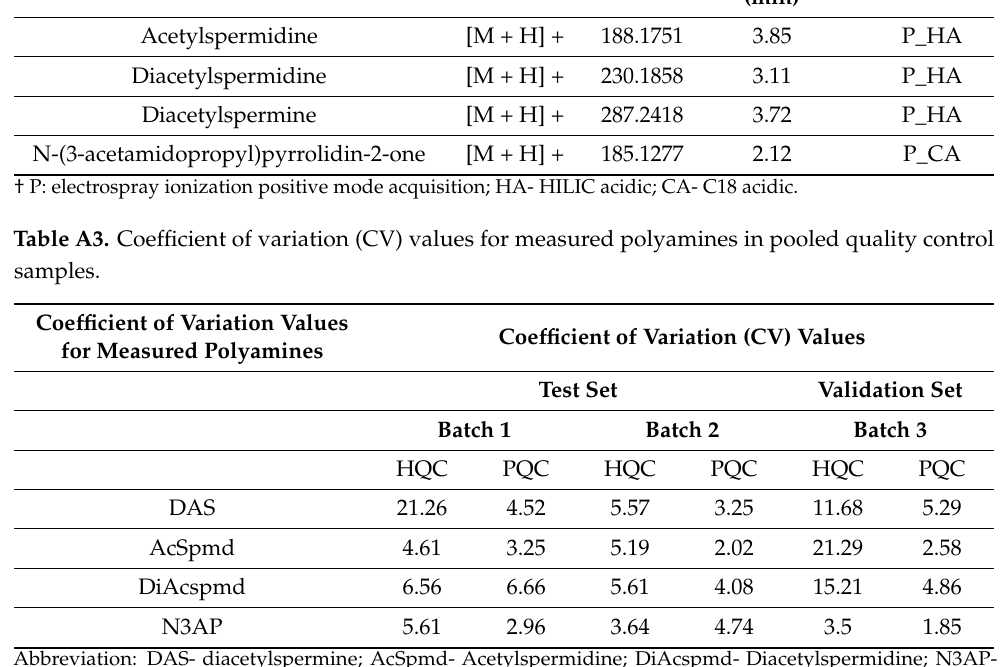
Table A4. Classification performances of plasma polyamines in distinguishing ovarian cancer cases from controls in the Test Set. All OvCa Cases ( n = 116) vs. Healthy Controls ( n = 71)